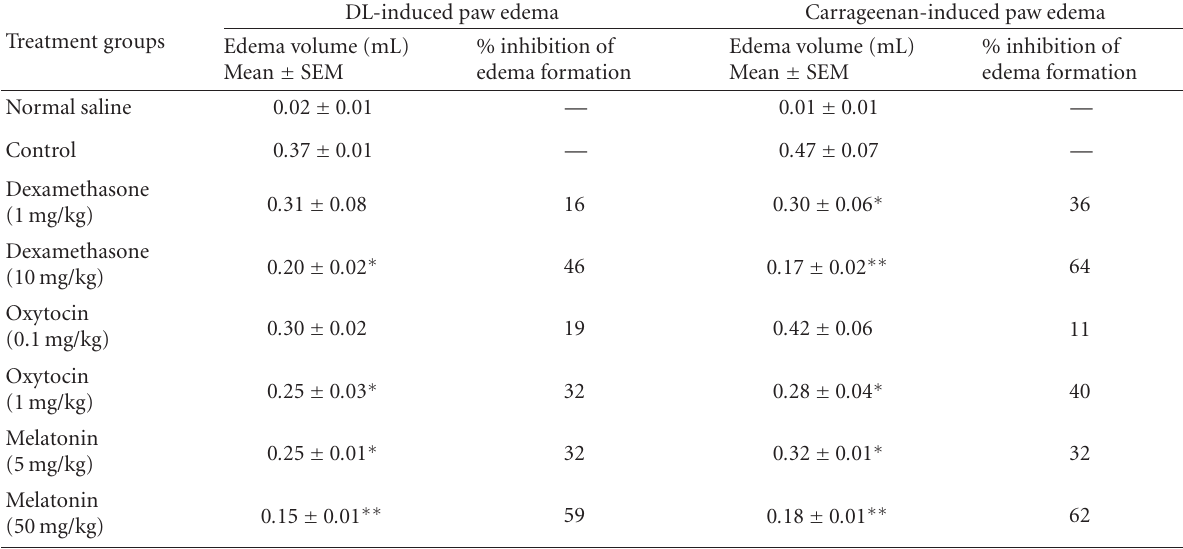
Table 1. E ff ect of various drugs on DL- and carrageenan-induced paw edema. Edema was induced by injecting 0.1mL of 1% so- lution of DL or carrageenan into subplantar surface of right-hind paw. The drugs were administered subcutaneously 30 minutes before injecting inflammagen. The edema volume was calculated at the time of peak inflammation (2 hours for DL and 4 hours for carrageenan). The values given are mean ± standard error of the mean ( n = 6). ∗ P < . 05, ∗∗ P < . 01 compared with respective